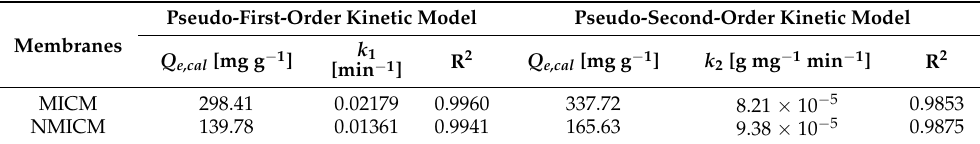
Table 1. Kinetic parameters for the pseudo-first-order and the pseudo-second-order kinetic models. Pseudo-First-Order Kinetic Model Pseudo-Second-Order Kinetic Membranes